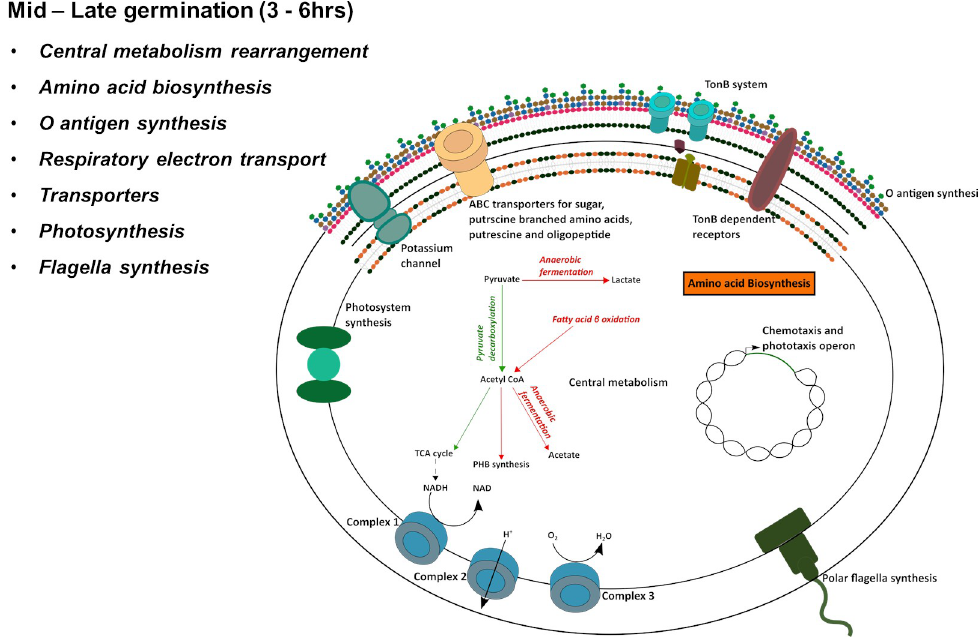
Fig 5. Diagram of cellular processes that undergo changes during the middle to late germination period (3 to 6 hrs.).